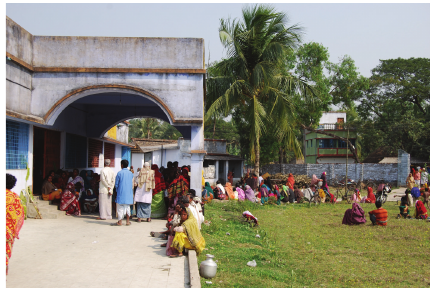
Figure 2: A very busy outdoor clinic in Dhaki, a rural village located in the Ganges river delta, south of Kolkata, India.